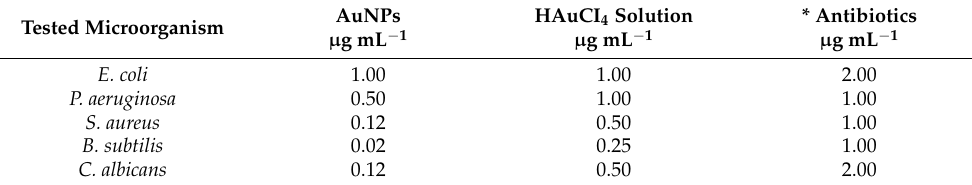
Table 3. MIC values of synthesized AC-AuNPs.